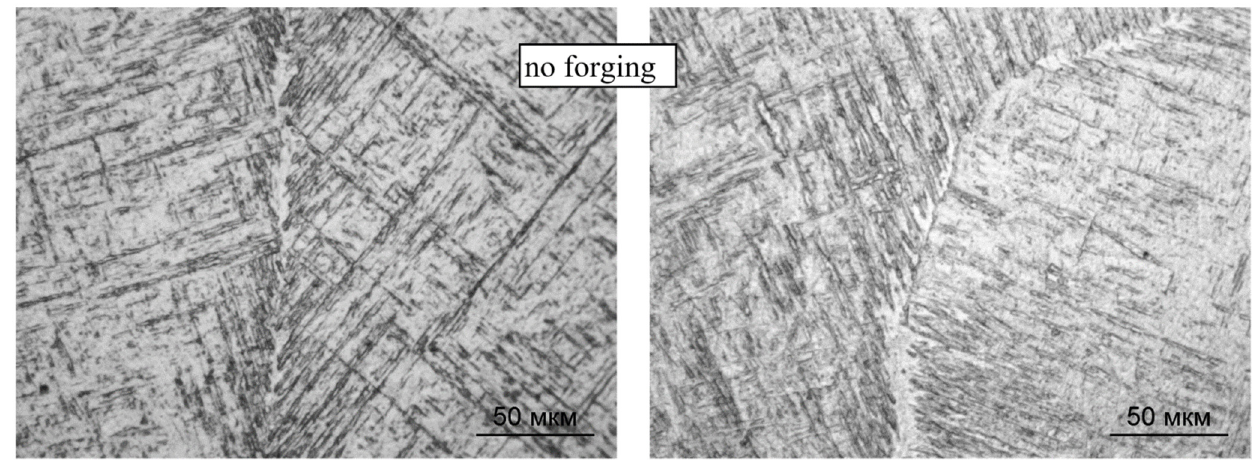
Figure 7. Boundaries between primary β -grains in the metal structure during CMT deposition without forging; ×500.